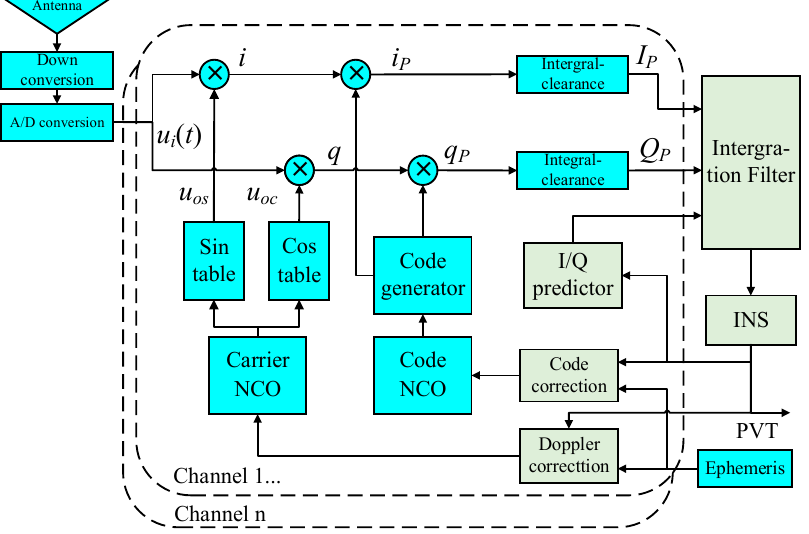
Figure 3. Ultra-tight integration considering code errors without new measurements.